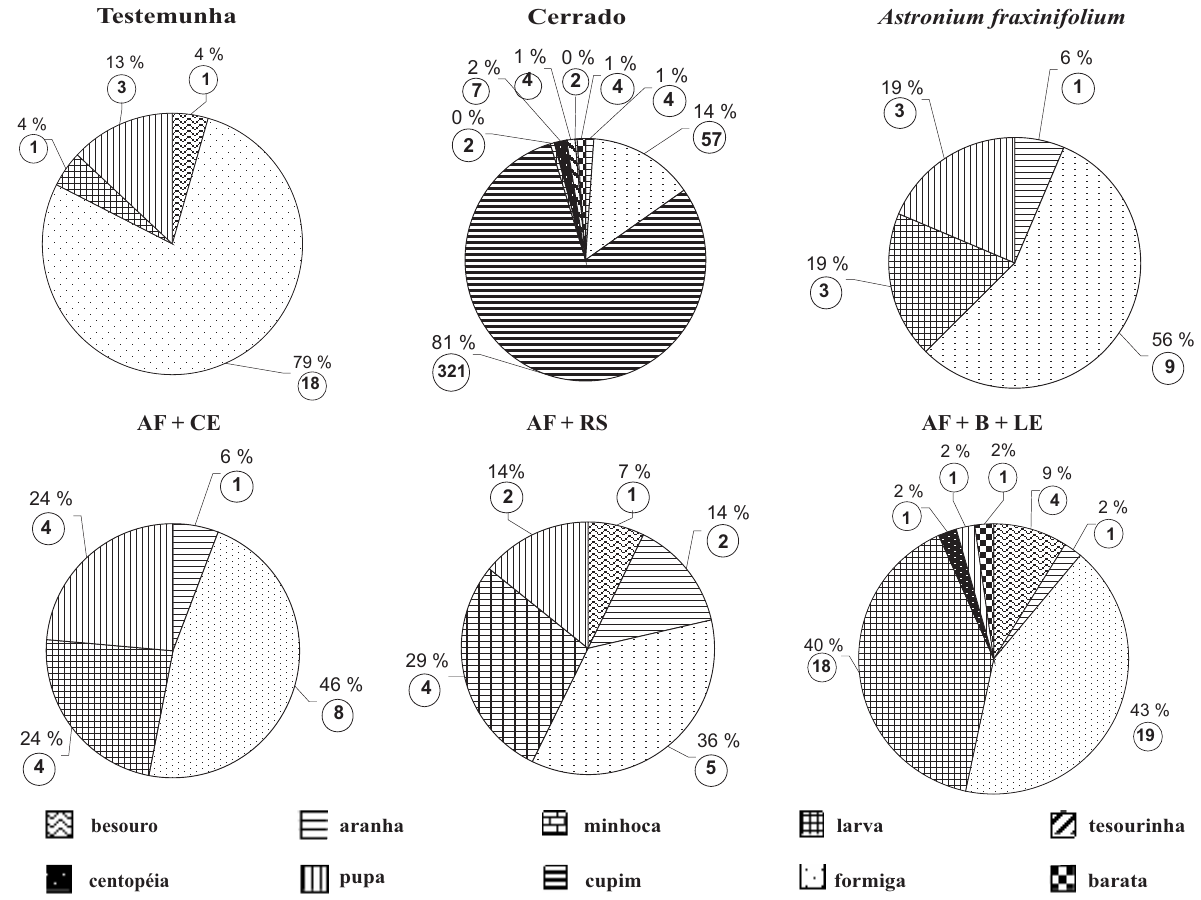
Figura 1. Distribuição dos macrorganismos coletados do solo nos diferentes tratamentos. Legenda: números contidos nos círculos são referentes ao número absoluto de macrorganismos. Astronium fraxinifolium + Canavalia ensiformis (AF + CE); Astronium fraxinifolium + Raphanus sativus (AF + RS); Astronium fraxinifolium + Brachiaria decumbens +lodo de esgoto (AF + B +